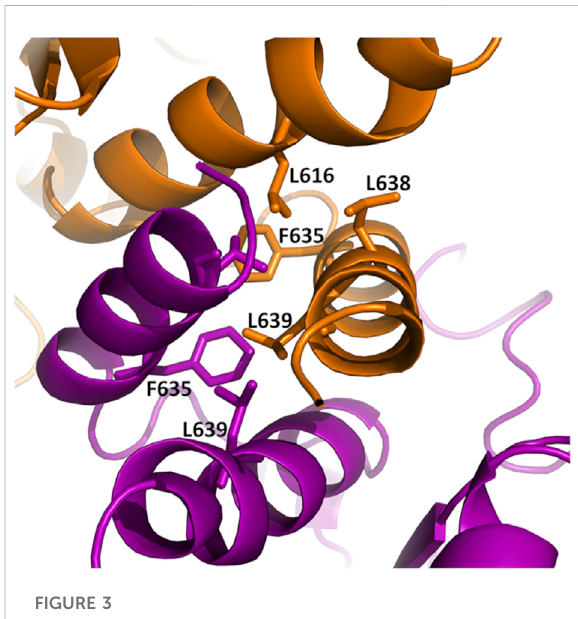
FIGURE 3 Cartoon representation of the dimerization interface of HtpG Mtb .Thetwochainsarerepresentedinorangeandprune.Key hydrophobic residues of the four-helix-bundle hydrophobic core are drawn in stick